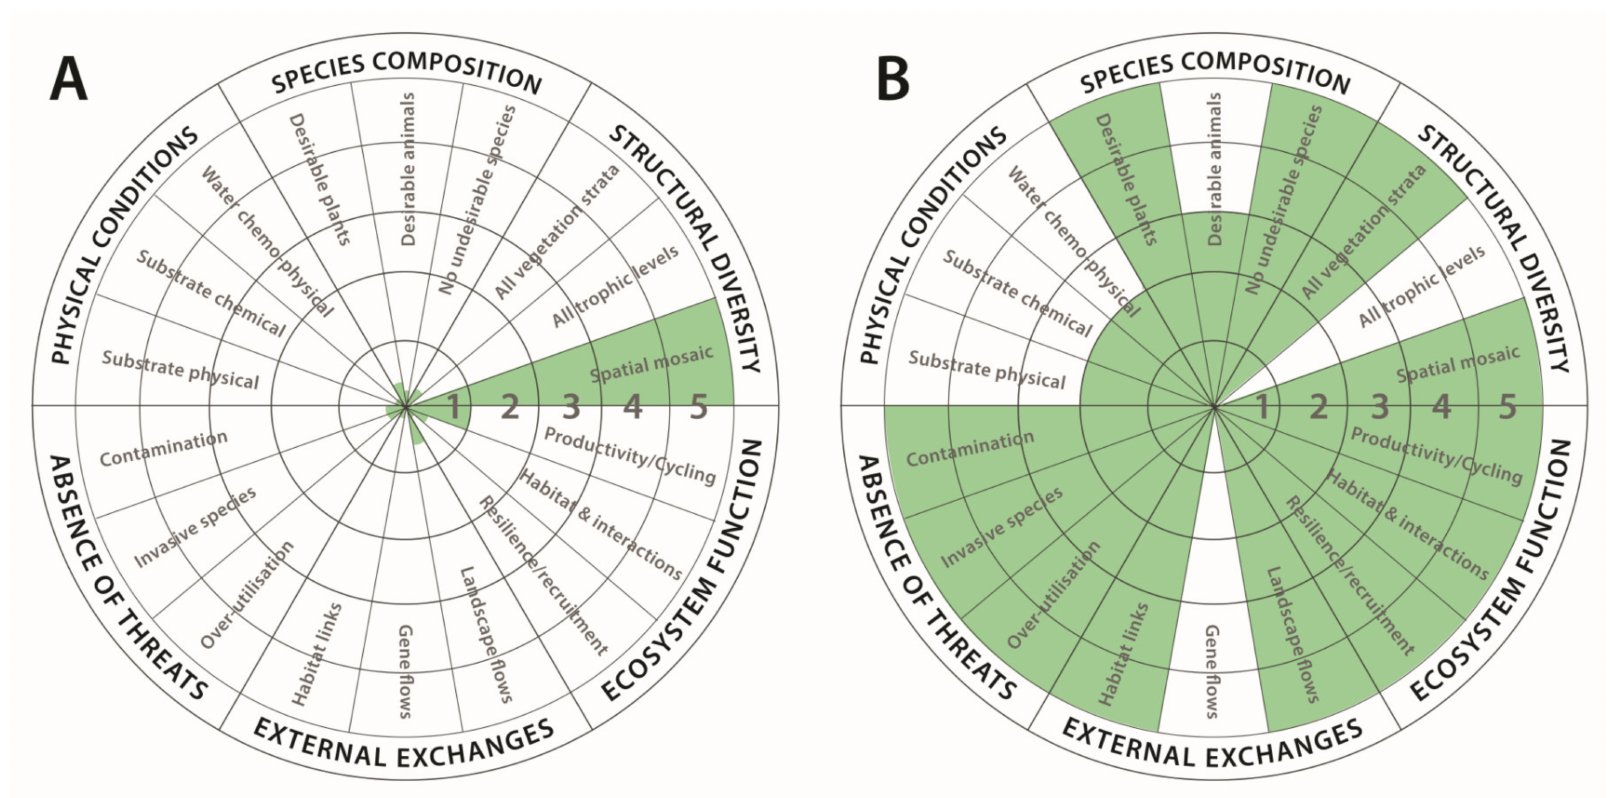
Figure 3. Remote sensing studies plotted on the ecological recovery wheel for monitoring projects (International Society for Ecological Restoration (SER)) based on their primary objective and rescaled by the sub-attribute spatial mosaic which had the highest number of studies at 59 ( A ). Potential application of remote sensing opportunities for monitoring in mine site rehabilitation ( B ). This figure was adapted from the ecological recovery wheel, accessed at http: // seraustralasia.com / wheel /